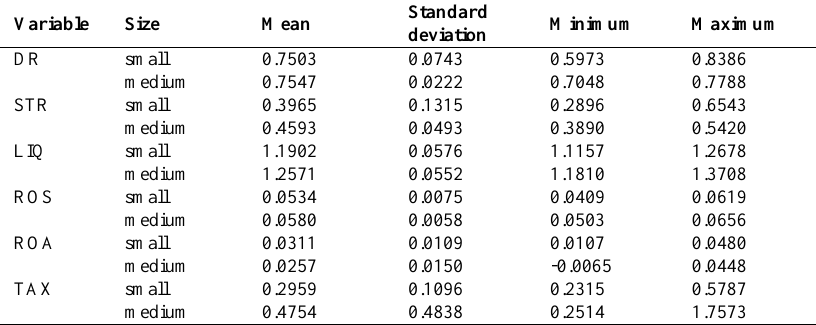
Table 1. Descriptive statistics for the period of years 2010–2018